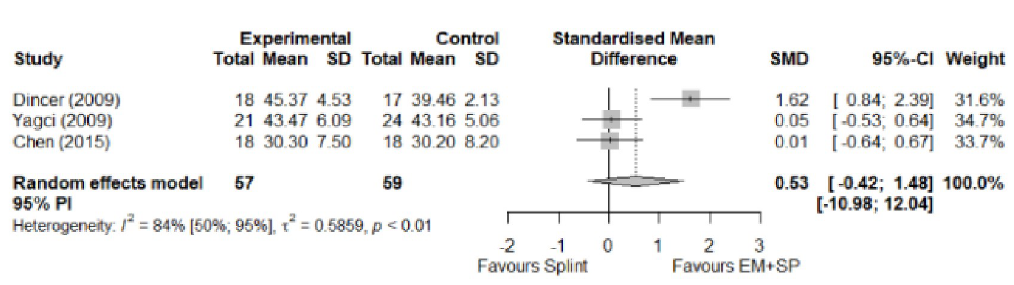
Fig 33. Analysis—Electrophysical modalities plus splint versus splinting (sensory velocity).